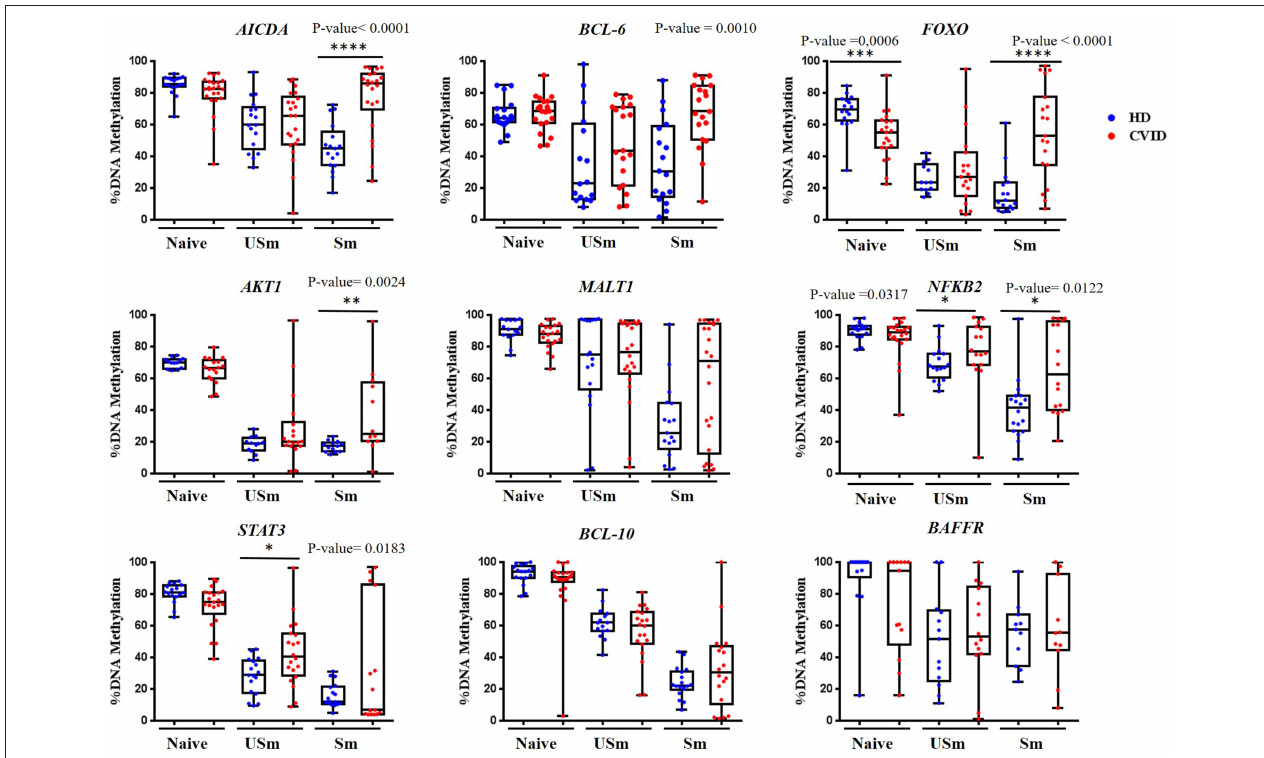
FIGURE 1 | Percentage of DNA methylation obtained by pyrosequencing for the selected CpG in different genes, represented as box and whiskers, in the B cell subsets naïve, unswitched (USm) and switched (Sm) memory B cells from healthy donors (in blue) and CVID patients (in red). Box represent mean with minimum to maximum. P -value of statistically significant differences by Mann-Whitney test are included (* p < 0.05; ** p < 0.01; *** p < 0.001; **** p <